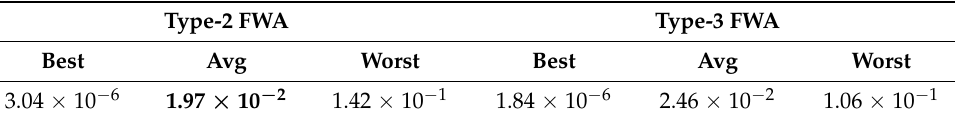
Table 5. First data period (future prediction, Brazil).